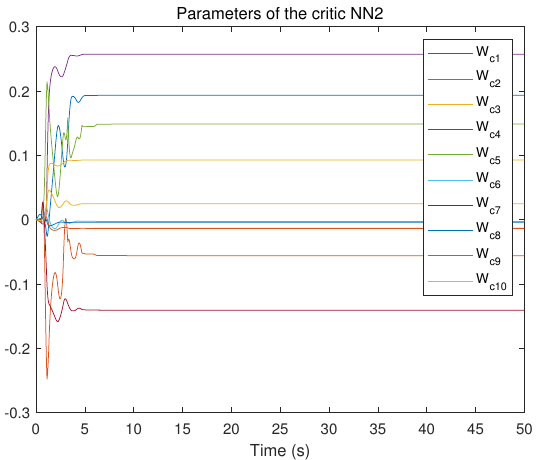
Figure 4. Convergence curves of the critic NN2 weights for player 2.